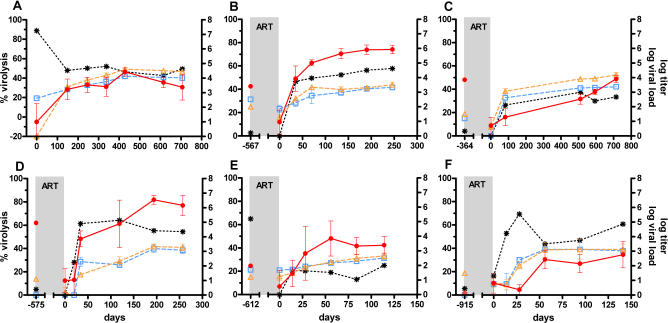
Longitudinal Assessment of Autologous Complement Lysis Activity in Patient PlasmaLysis activity against autologous virus (red circles) of plasma from six acutely HIV-1-infected patients was measured longitudinally and plotted against anti-gp120 titers (orange triangles), anti-gp41 titers (blue squares), and viral load (asterisks). At the first data point, patients were treatment-naïve and acutely HIV infected. All patients (except patient 022) subsequently went on antiretroviral therapy for the indicated time periods. Time point 0 was assigned to the date of treatment interruption and the remaining time points were calculated according to this time point. (A) Patient 022 (treatment-naïve), (B) patient 015, (C) patient 003, (D) patient 016, (E) patient 026, and (F) patient 002.